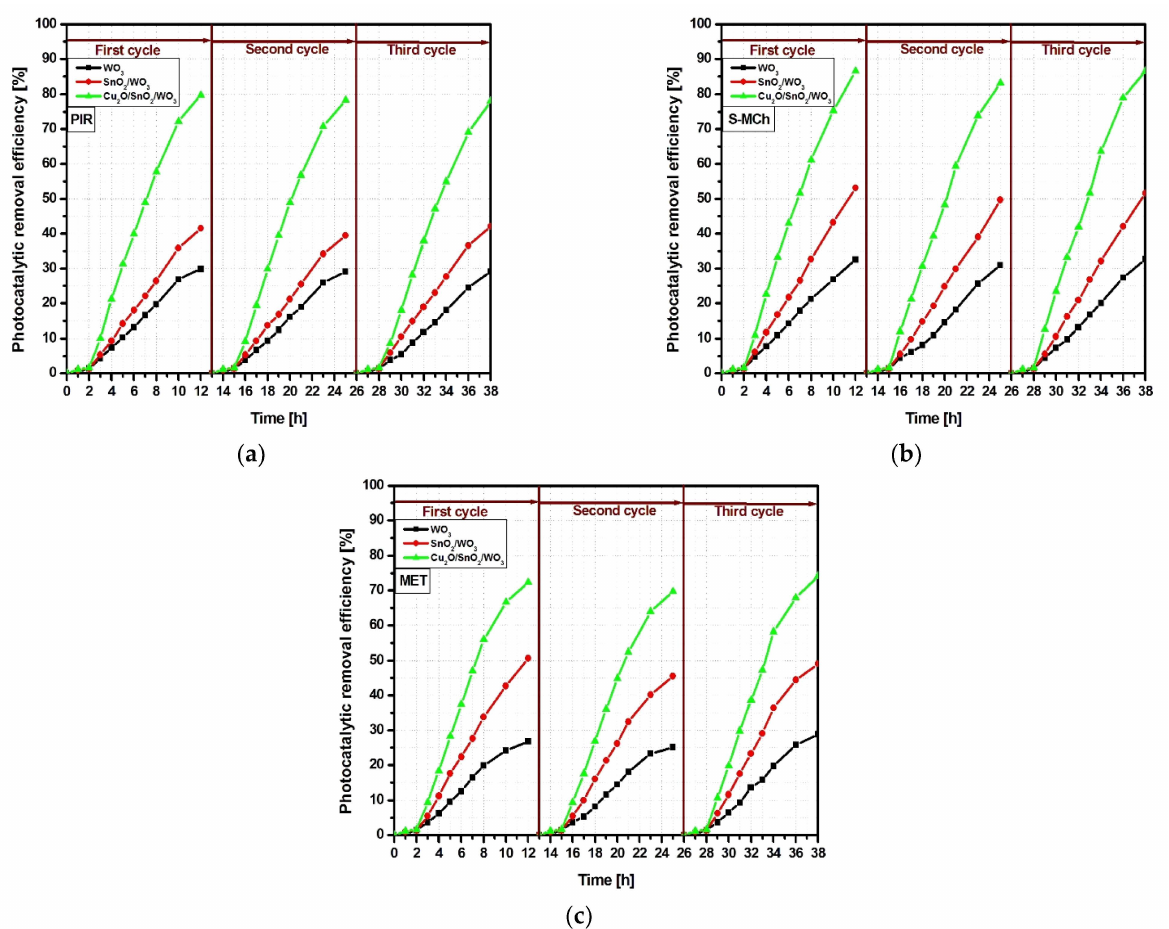
Figure 7. Photocatalytic activity during the 3-cycle sample reusability for ( a ) PIR, ( b ) S-MCh and ( c ) MET